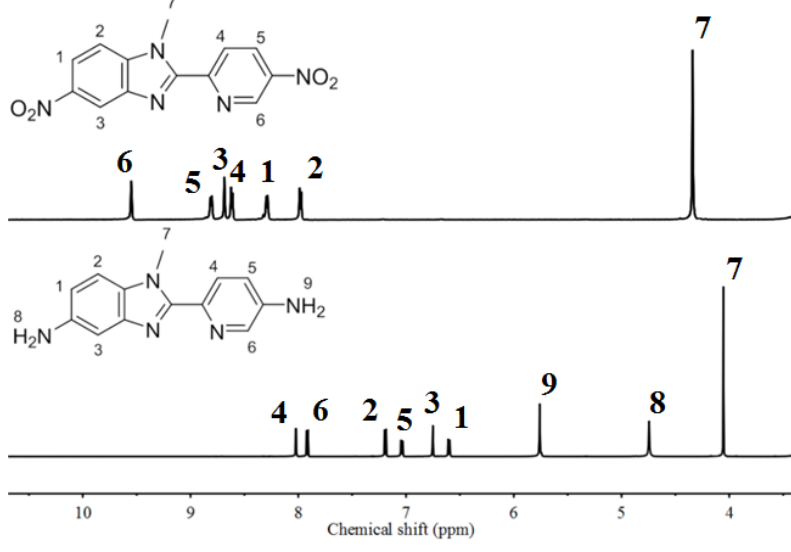
Figure 1. 1 H-NMR spectra of three and PyMePABZ.